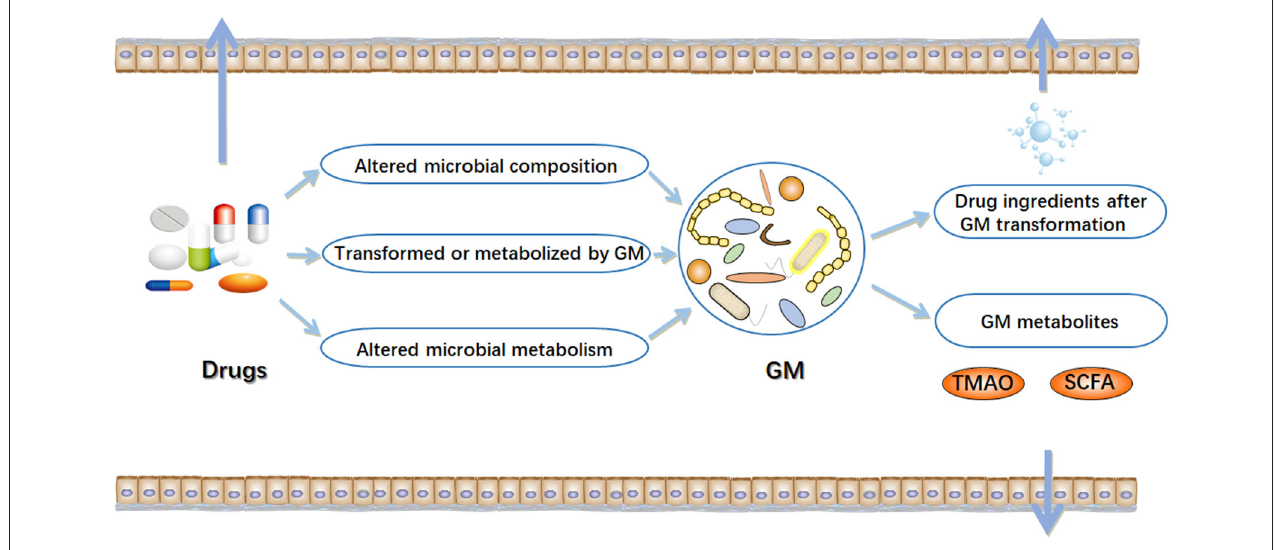
FIGURE 1 | Interactions between drugs and gut microbiome (GM). In the intestinal tract, there are complex interactions between drugs and microorganisms. On the one hand, drugs can result in alterations in the composition and function of gut microbiome. On the other hand, gut microbiome may alter chemical structure of drugs, and directly or indirectly affect drug efficacy. TMAO, trimethylamine N-oxide; SCFA, short-chain fatty acids. Arrow mark indicates Drugs, GM metabolites and drug ingredients after GM transformation are transferred outside the